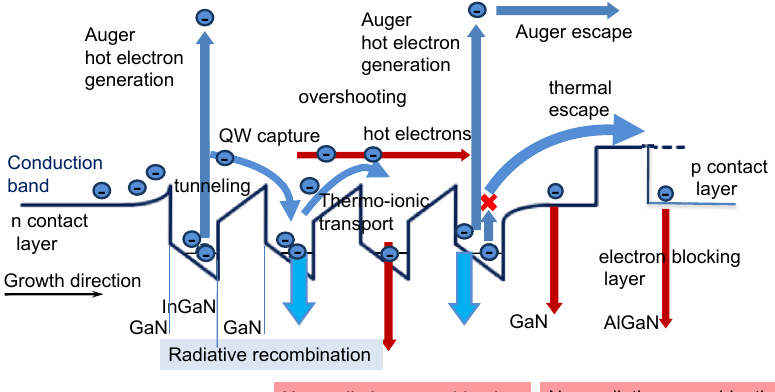
Figure 6: Schematics of the phenomena occurring in LEDs best captured by nonequilibrium computingtechniquessuch as NEGF or Monte